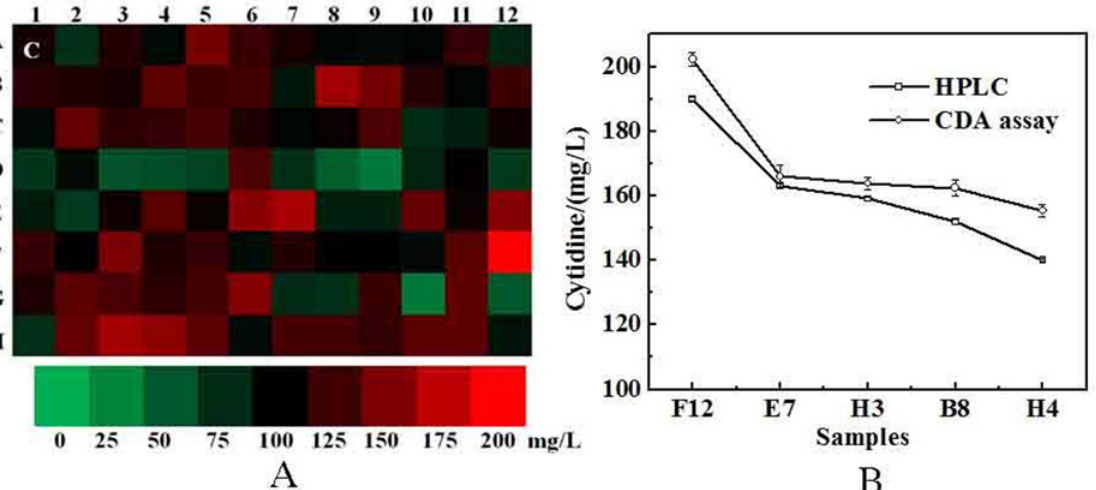
Fig 5. Screening high cytidine-producing strains using CDA assay. (A) Production of cytidine in a 96-well deep-hole culture plate from randomly picked mutation strains. The letters and numbers represented row and column number of the 96-well deep-hole culture plate respectively. C: Control, A1 represented for cytidine concentration of parent strain. (B) Top five samples (F12, E7, H3, B8 and H4) determined using CDA assay was chosen to detect cytidine by HPLC. CDA assay and HPLC had a positive correlation on cytidine concentration. Each experiment runs in triplicate.